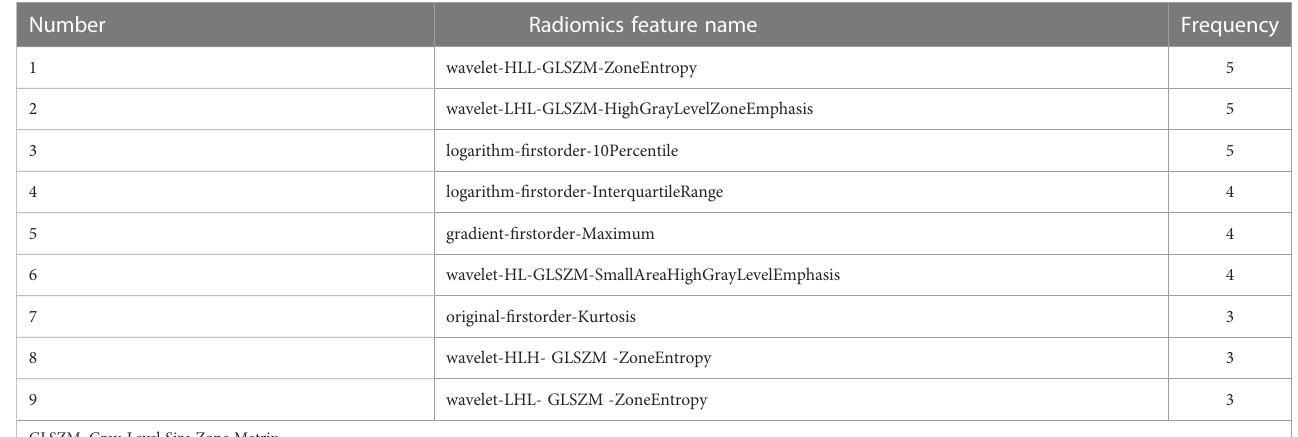
TABLE 3 Details of the selected features in the developed radiomics